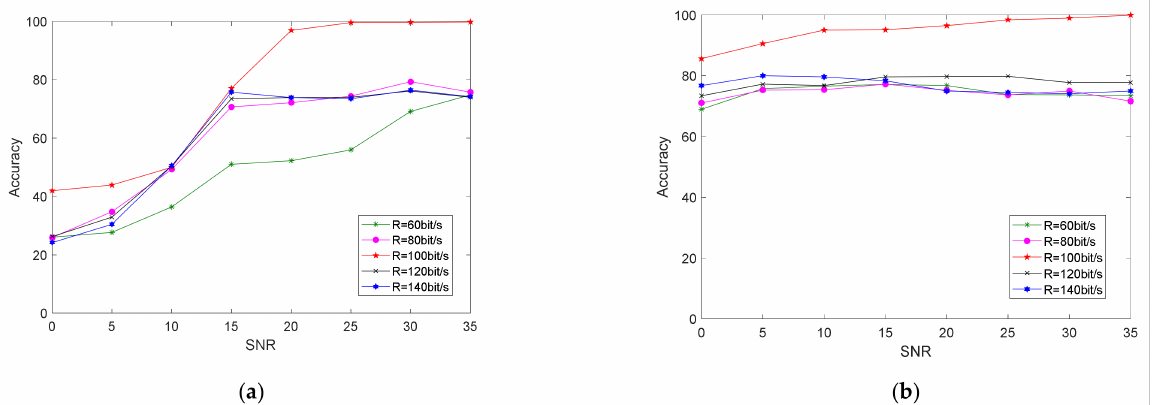
Figure 13. After changing the data information rate of the test set, the classification accuracy results using ( a ) bispectral method and ( b ) proposed method under different signal-to-noise ratio conditions.